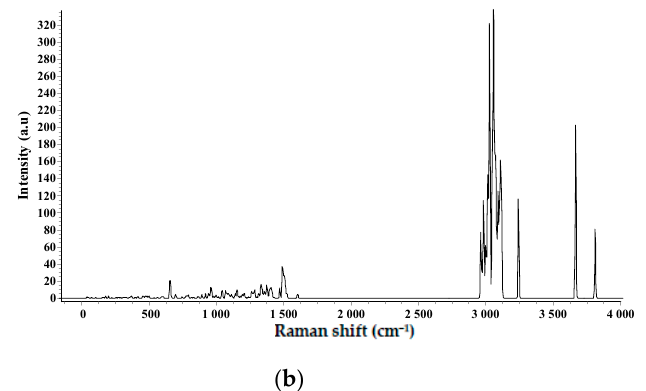
Figure 4. ( a ) FT-Raman spectrum of stanozolone molecule in the wavenumber range 4000–0 cm − 1 ; ( b ) The simulated Raman spectrum of stanozolone computed with a B3LYP/6-311G (d, p) level of theory. Biosensors 2017 , 7 , x FOR PEER REVIEW